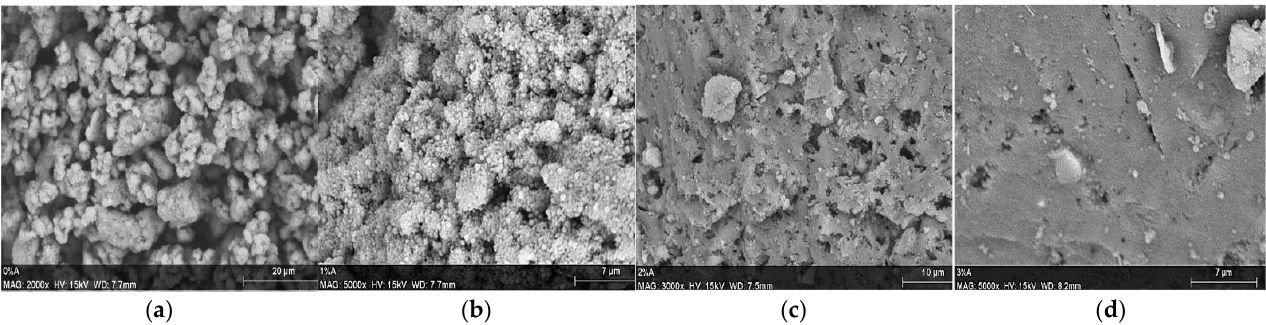
Figure 6. Scanning Electron Microscopy of the geopolymer ( a ) and composites filled with 1 wt% ( b ), 2 wt% ( c ), and 3 wt% ( d ) of the magnetic nanoparticles.